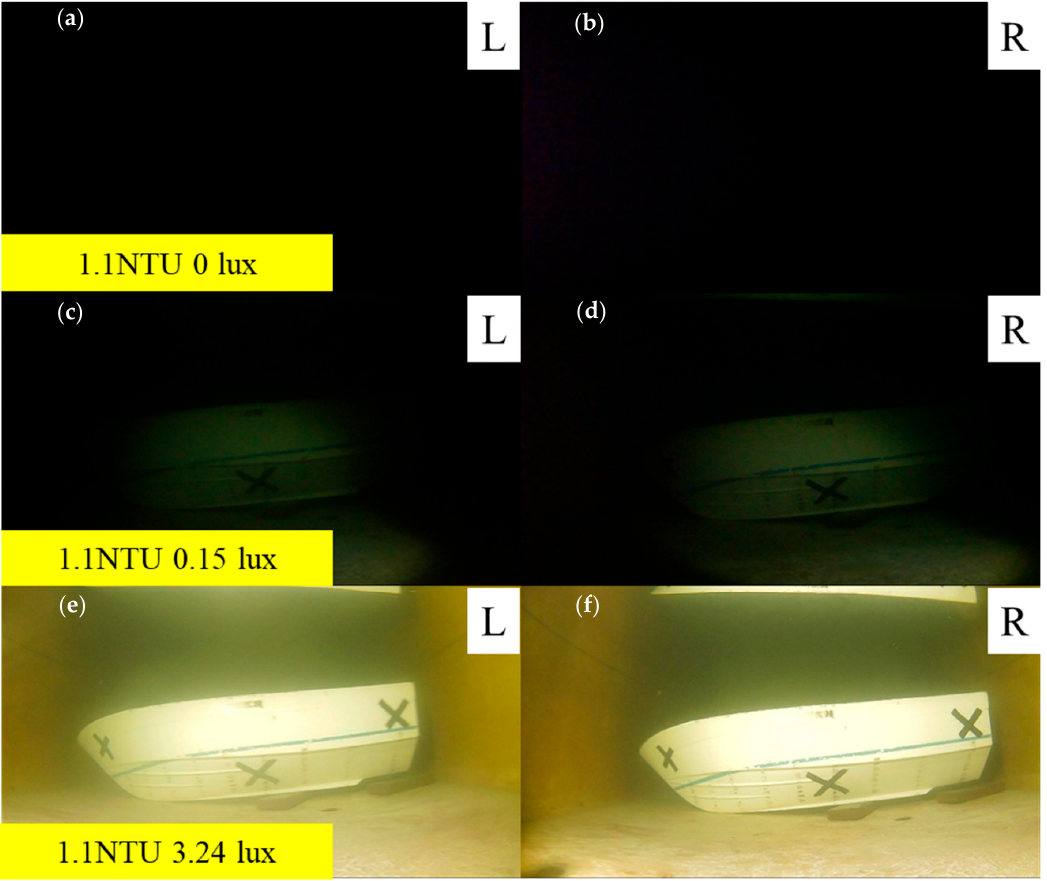
Figure 27. Case 2: Images captured from left and right in the underwater environment with a turbidity of 1.1 NTU and an illuminance parameter of 0 lux ( a , b ); 0.15 lux ( c , d ); and 3.24 lux ( e , f ).